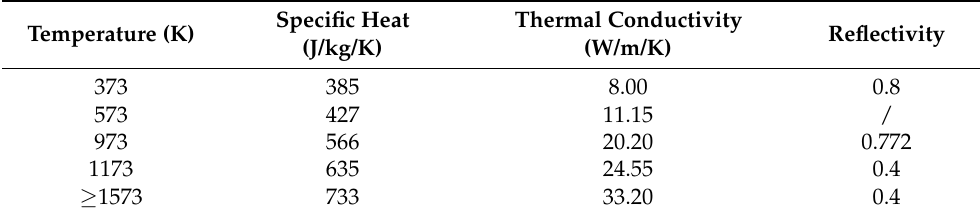
Table 2. Temperature-dependent material properties of the DD6 single-crystal superalloy.